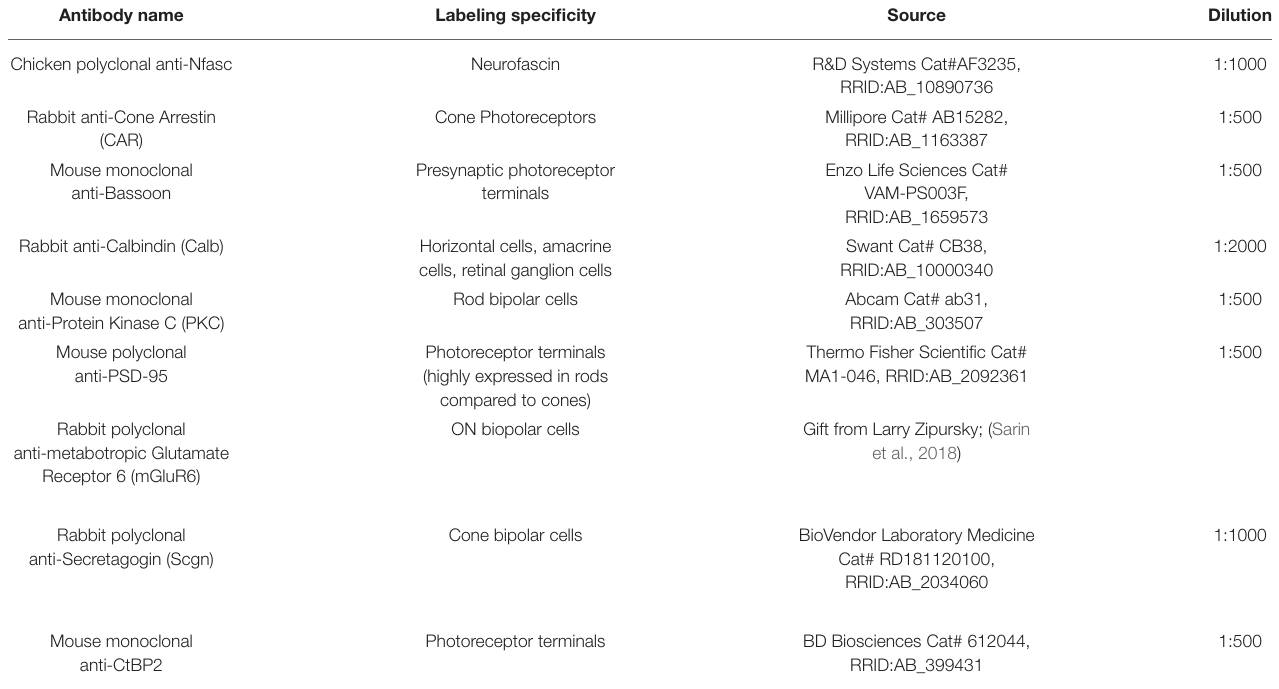
TABLE 1 | List of primary antibodies used in this